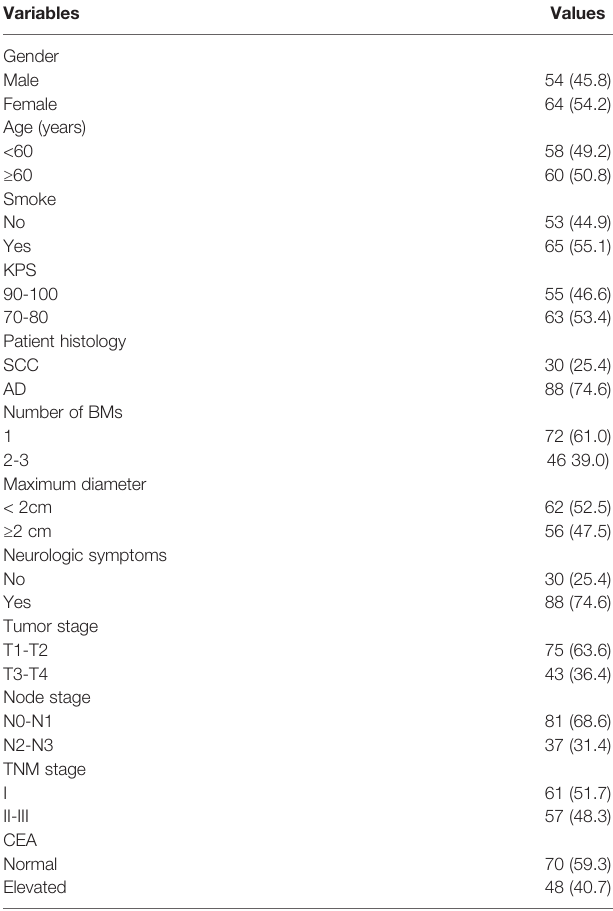
TABLE 1 | The clinical characteristics of all NSCLC patients with BM.